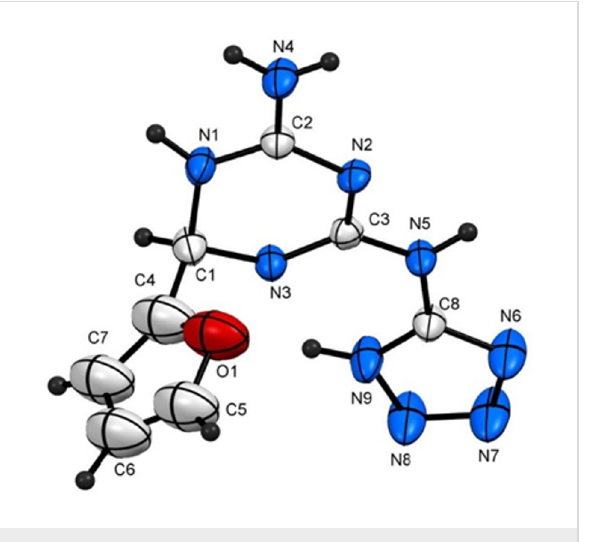
Figure 1: ORTEP diagram of compound 4i .